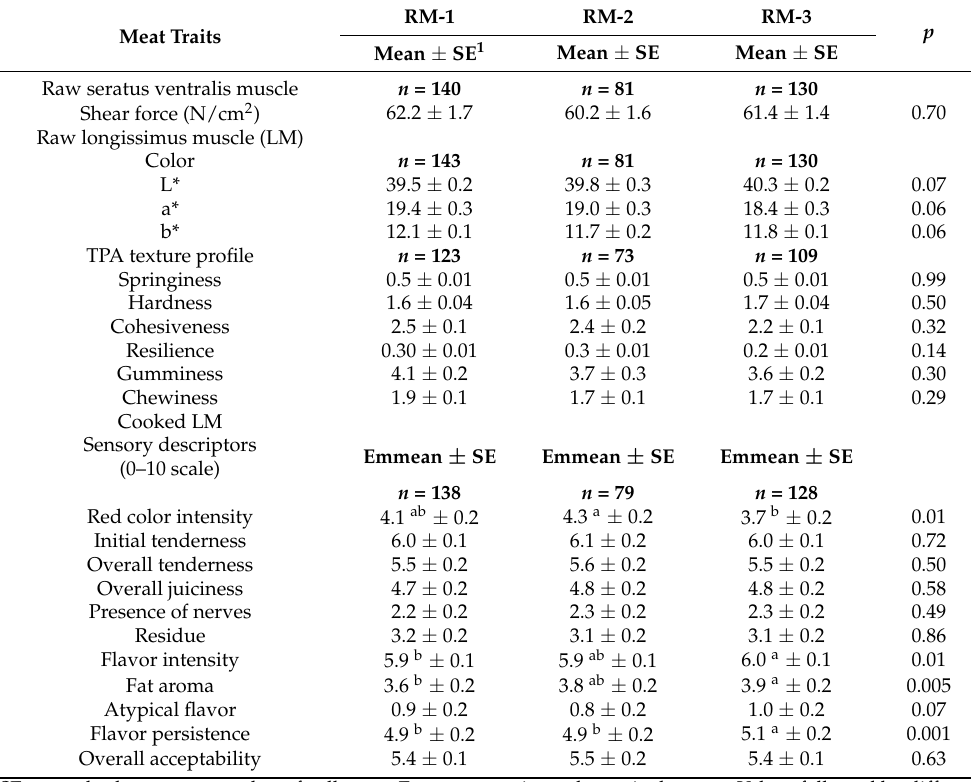
Table 7. Effects of the three rearing managements (RM) applied during the whole cull cows’ life on meat